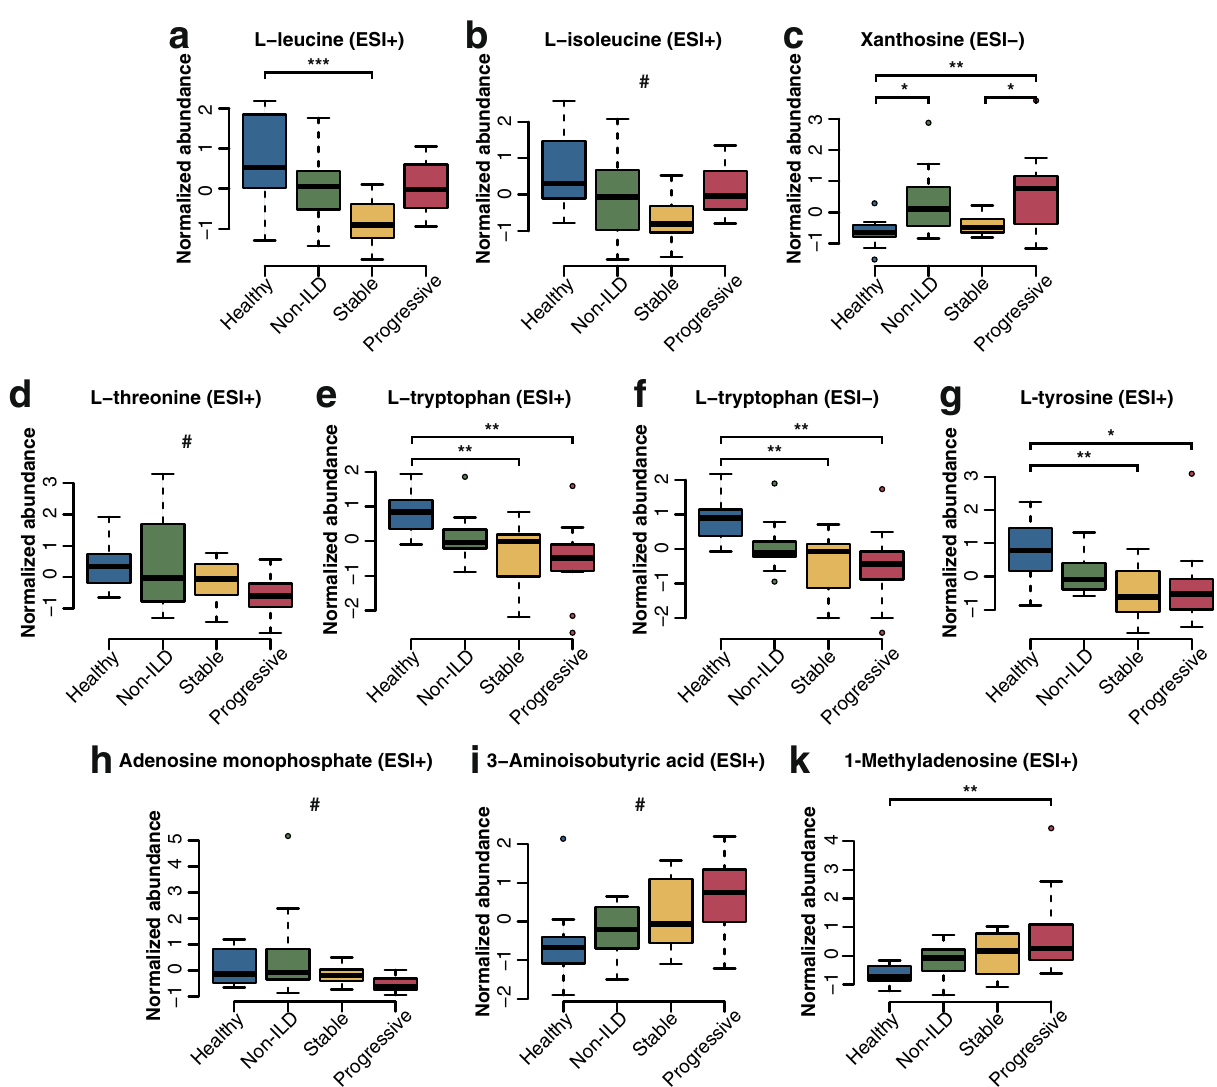
Figure 4. Significant metabolites in univariate analysis of Z-score-normalized peak areas and PLS-DA analysis. * = p ≤ 0.05, ** = p ≤ 0.01, *** = p ≤ 0.001, # = not significant in univariate analysis and no post-hoc test performed. N = 12 per